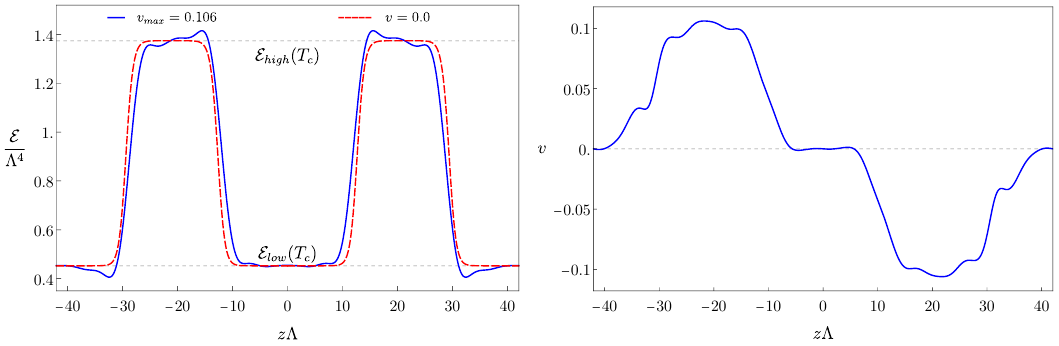
Figure 8 . (Left) Initial configuration (dashed red) used to generate two domains in motion (solid blue) that will collide with each other. (Right) Fluid velocity for the domains in motion on the